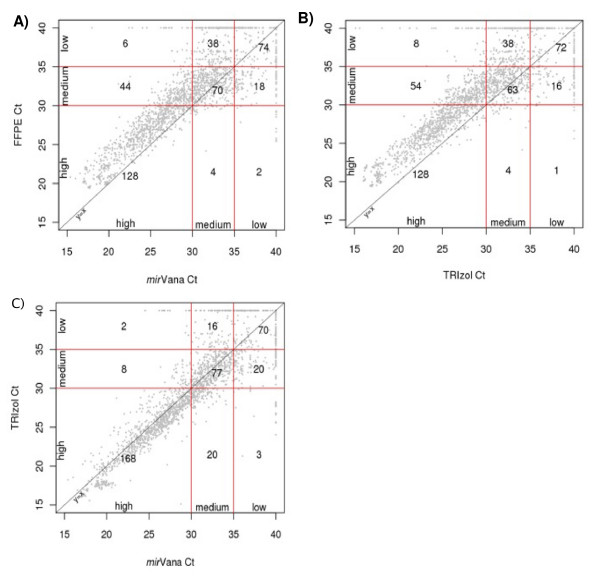
Comparison of miR abundance in paired fresh-frozen and FFPE tissues, using different RNA extraction methods. Plots show the comparison of Ct values for three normal and three mantle cell lymphoma samples by the three different extraction methods: A) FFPE (RecoverAll) vs. mirVana; B) FFPE (RecoverAll) vs. TRIzol; C) TRIzol vs. mirVana. Red lines delineate the abundance strata for each extraction method, with numbers indicating the average number of miRs per sample in each zone. For example, in the FFPE vs. mirVana plot (Figure 5A), 44 miRs are high abundance by mirVana and medium abundance by FFPE (RecoverAll), but only 4 miRs are high abundance by FFPE (RecoverAll) and medium abundance by mirVana.